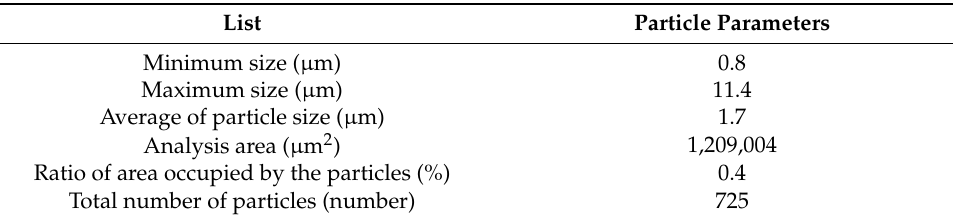
Figure 4. Sample particle distribution based on size. Table 1. Details of the size and density of particles.